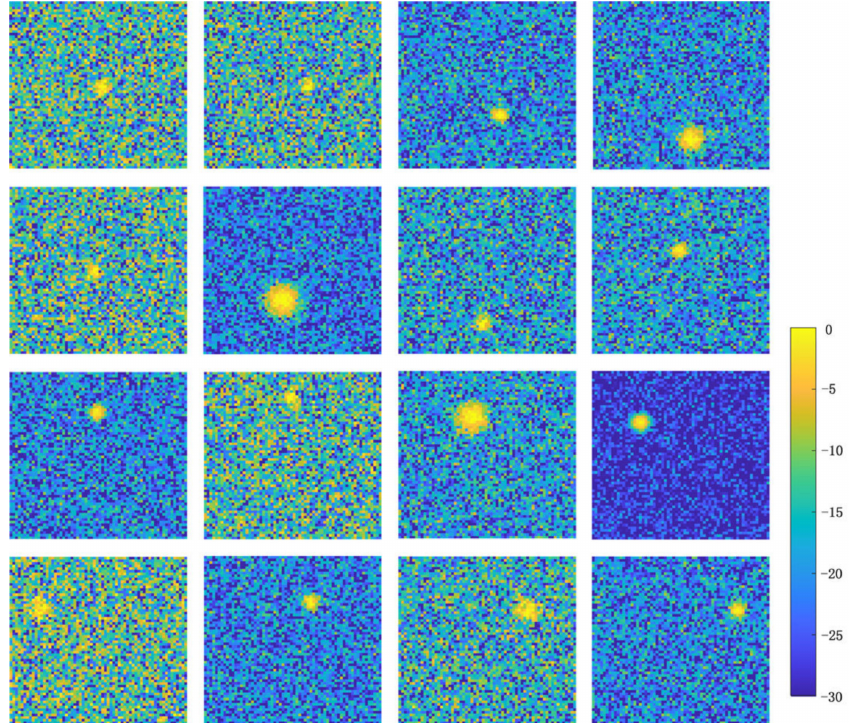
Figure 12. Feature visualization of the last layer of 3D CNN